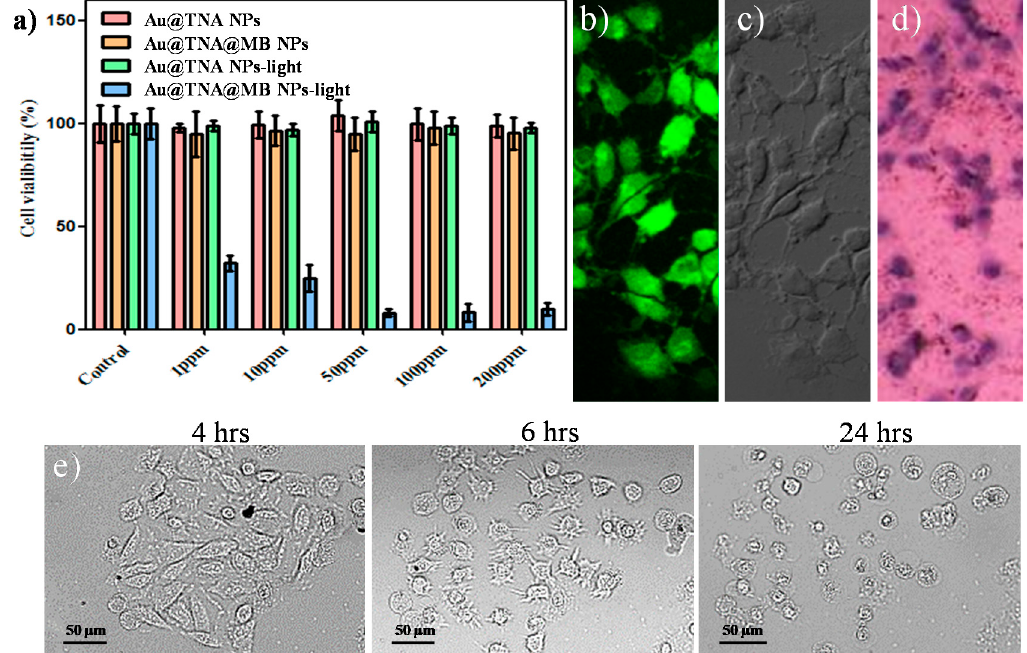
Figure 4. ( a ) Thiazolyl blue tetrazolium bromide (MTT) assay of HeLa cells cotreated with